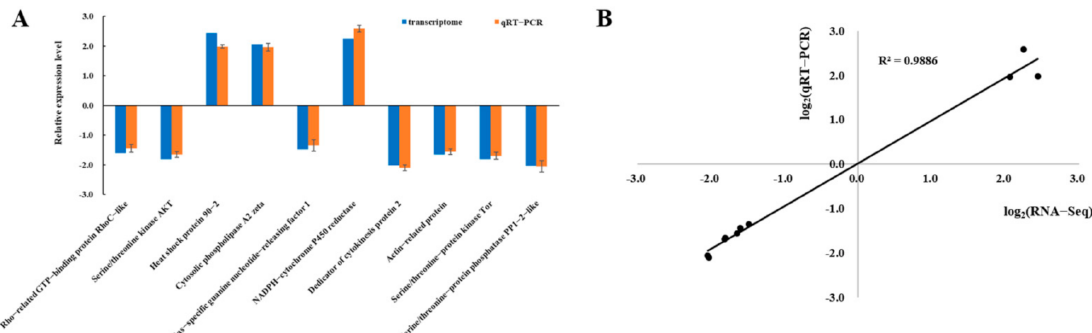
Figure 2. Verification of the expression of 10 selected differentially expressed unigenes by qRT-PCR. ( A ) The expression levels of the selected unigenes were measured using qRT-PCR. The qRT-PCR and transcriptome columns represent the mean average delta–delta Ct values and the log2FoldChange value, respectively. ( B ) The scatter plots show the R-squared (R 2 ) and linear regression between the transcriptome data and qRT-PCR values.